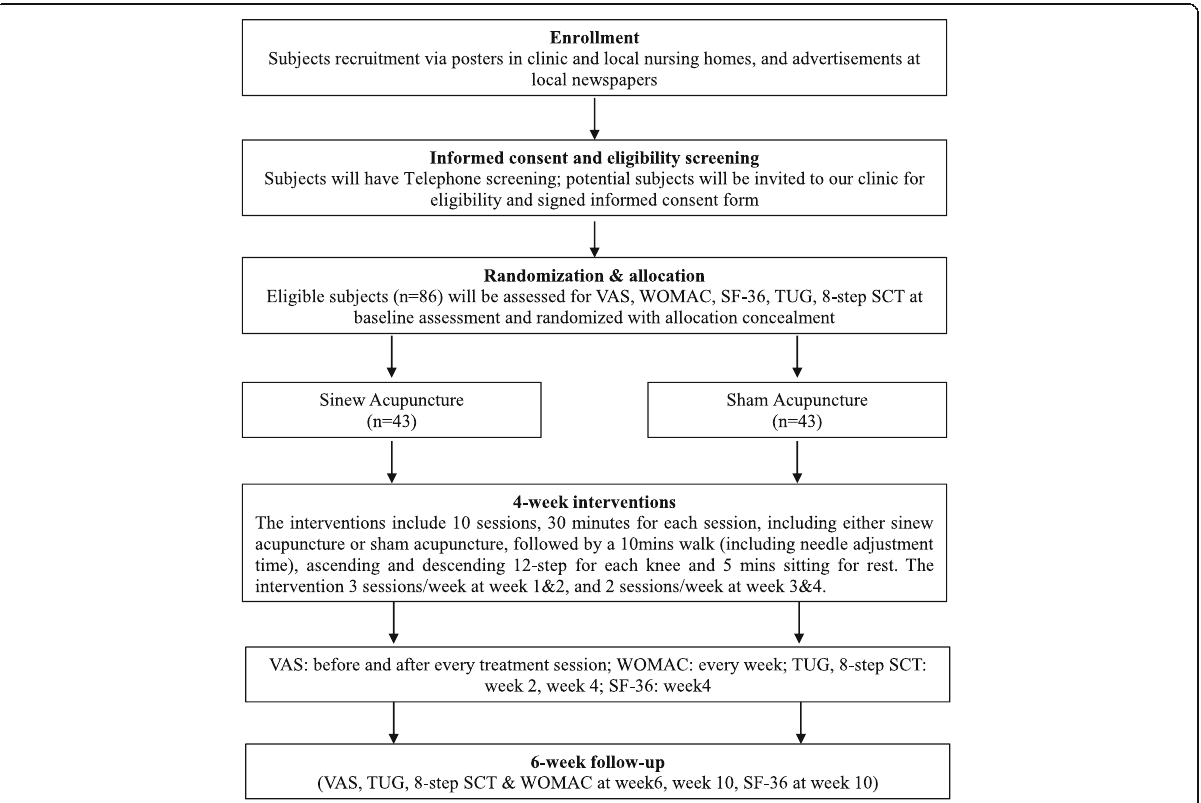
Fig. 1 Flow diagram of the study protocol. Assessment measures will be performed as follows: (1) Pain: VAS (visual analogue scale) and WOMAC (Western Ontario & McMasters University Osteoarthritis Index); (2) Functional movement: TUG (Timed up & Go Test) and 8-step SCT (Stair Climb Test); (3) Quality of life: Short Form-36 (SF-36); (4) Credibility test (end of weeks 2 & 4); (5) Test of blinding success (end of week 4); (6) Patient diary